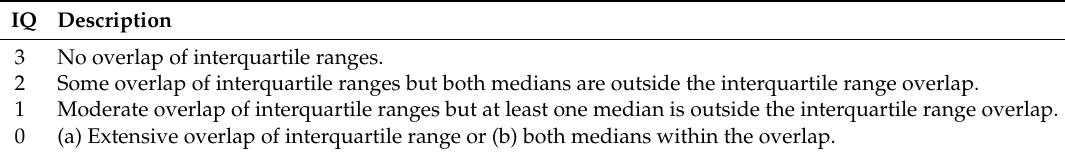
Figure 3. Small black squares represent median numbers. Boxes represent interquartile ranges (box-and-whisker plots of each plankton metric: blue-green algae ( a ), BP phytoplankton ( b ), BP zooplankton ( c ), BP benthic macroinvertebrate ( d ), FBI ( e ), and large Daphnia ( f ) used to discriminate between reference and impaired sites; 25–75% percentiles). Range bars represent maximum and minimum values. Table 4. Inter-Quartile (IQ) classes in the box-and-whisker